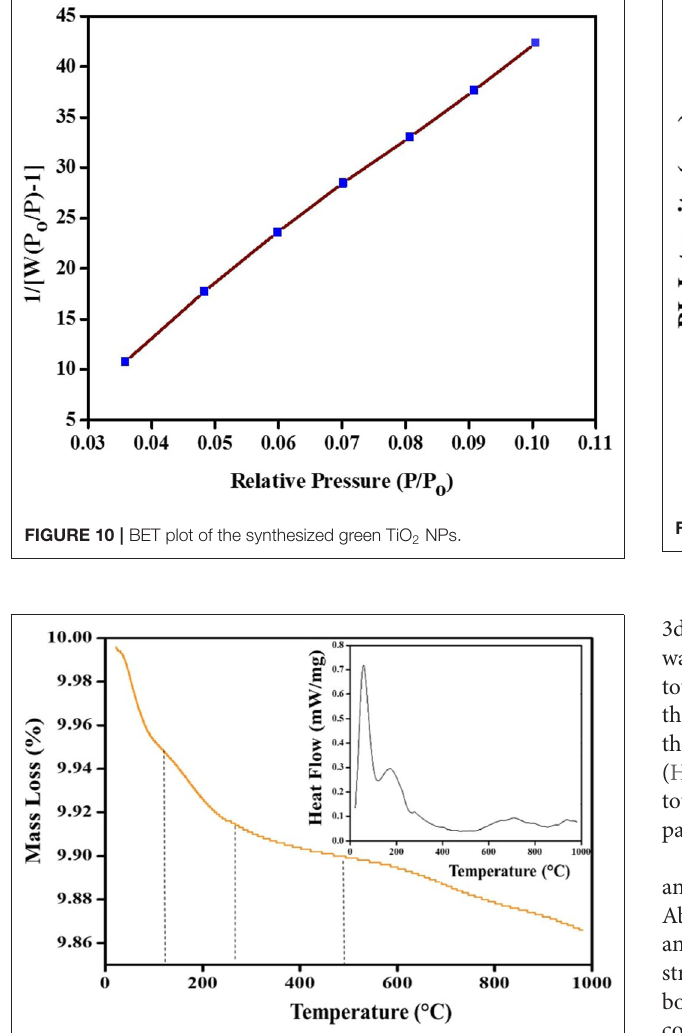
FIGURE 11 | The TGA and DSC (inset) curves of the synthesized green TiO 2 NPs.